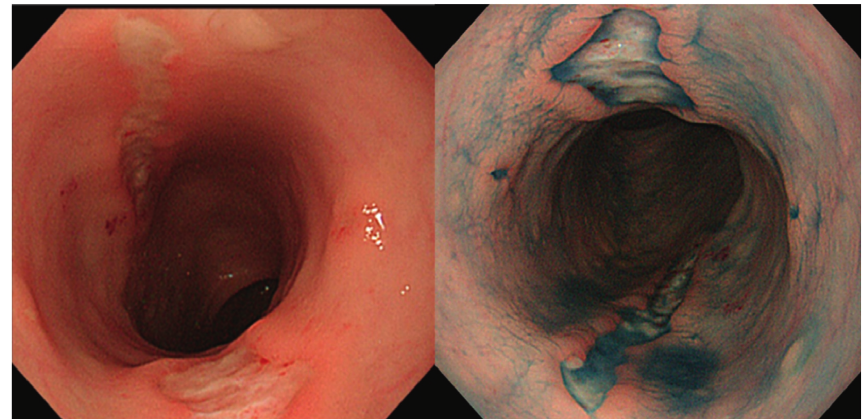
Figure 3: Colonoscopy showed rectal longitudinal